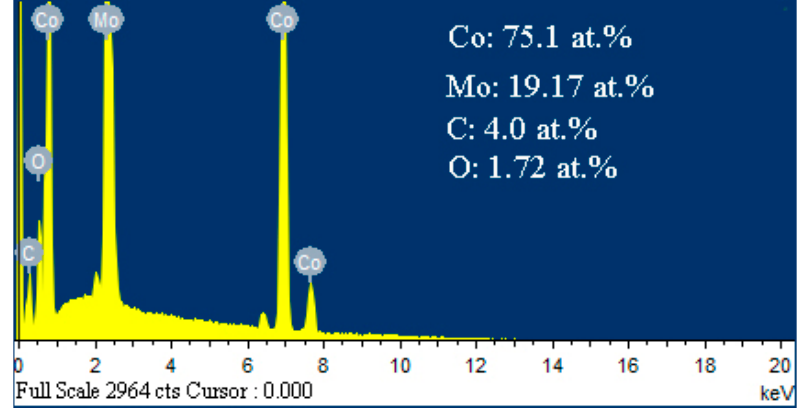
Figure 11. EDS spectrum and chemical composition of Co-Mo alloy coating.